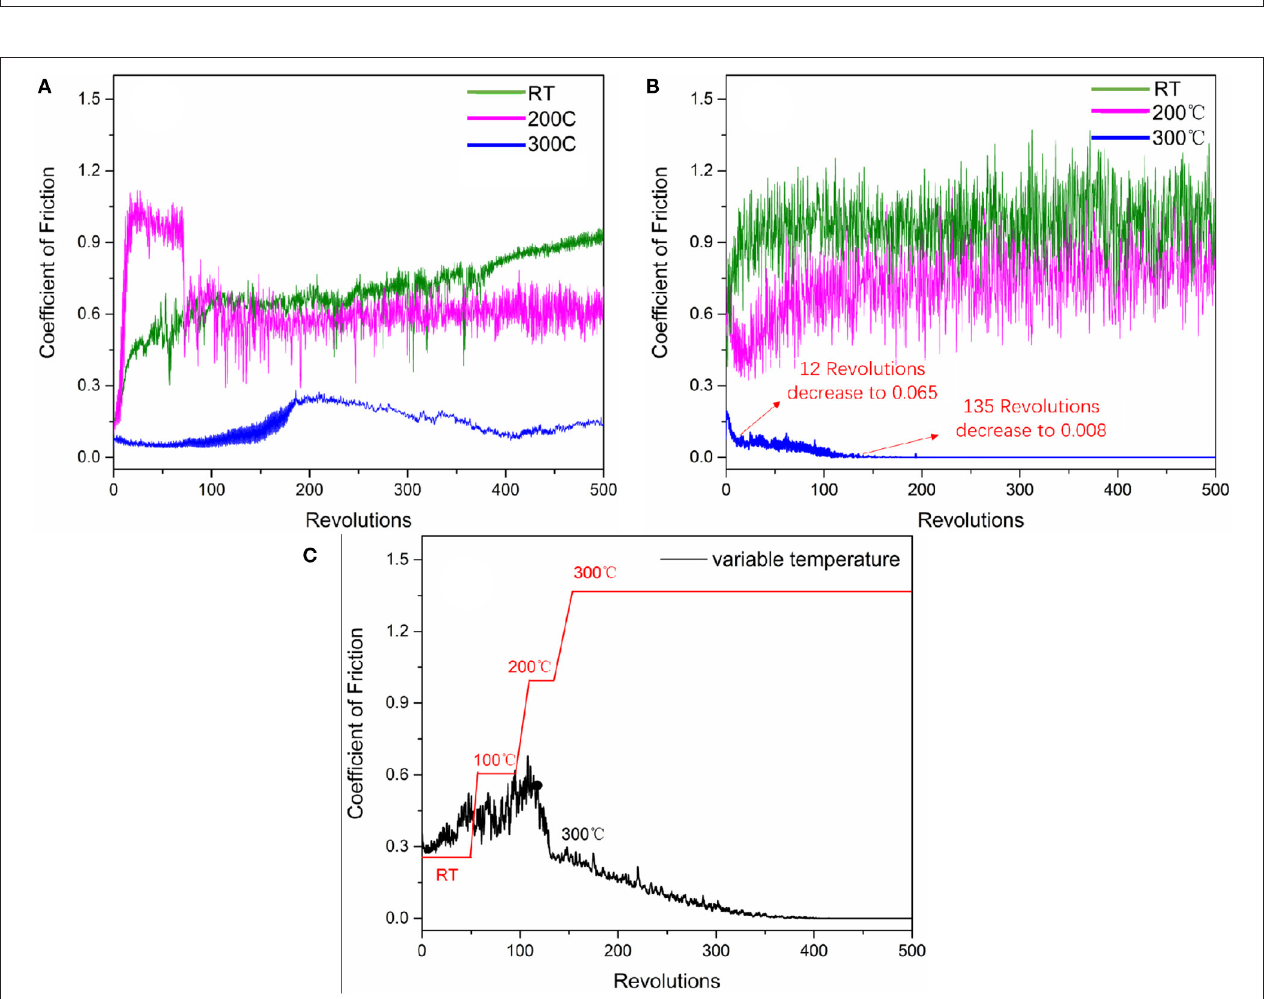
FIGURE 4 | COF behavior of (A) Sb 2 O 3 , (B) Sb 2 O 3 -MSH/C coatings tested under different temperature comdition, and (C) Sb 2 O 3 -MSH/C coating continuously monitored during temperature ramping from the RT up to 300 ◦ C. Due to the limitation of furnace power, the heating rate for the temperature ranges of RT-100 ◦ C, 100–200 ◦ C, 200–300 ◦ C has been changed from 2.08 ◦ C/s to 1.11 ◦ C/s, and 0.83 ◦ C/s, respectively.